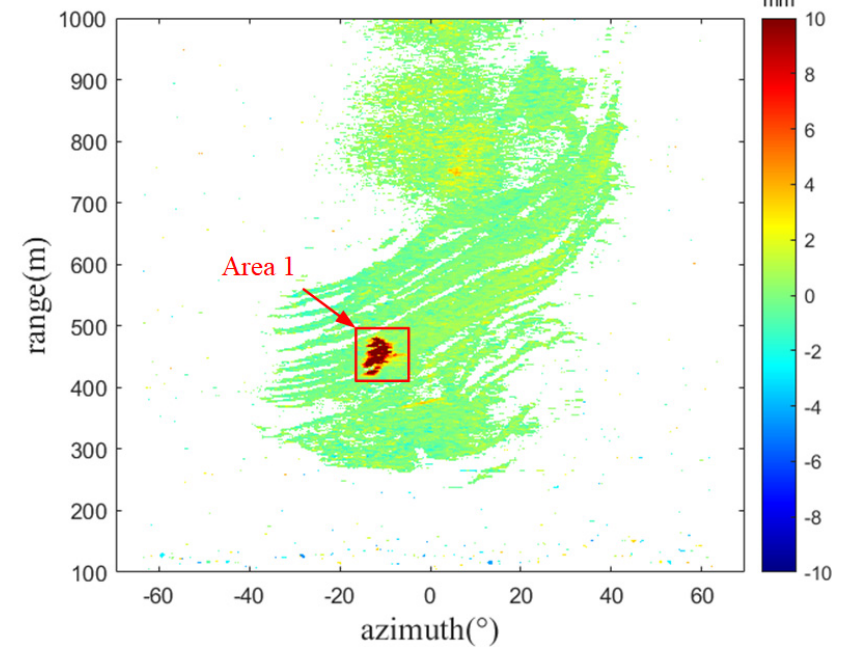
Figure 7. Cumulative deformation diagram.